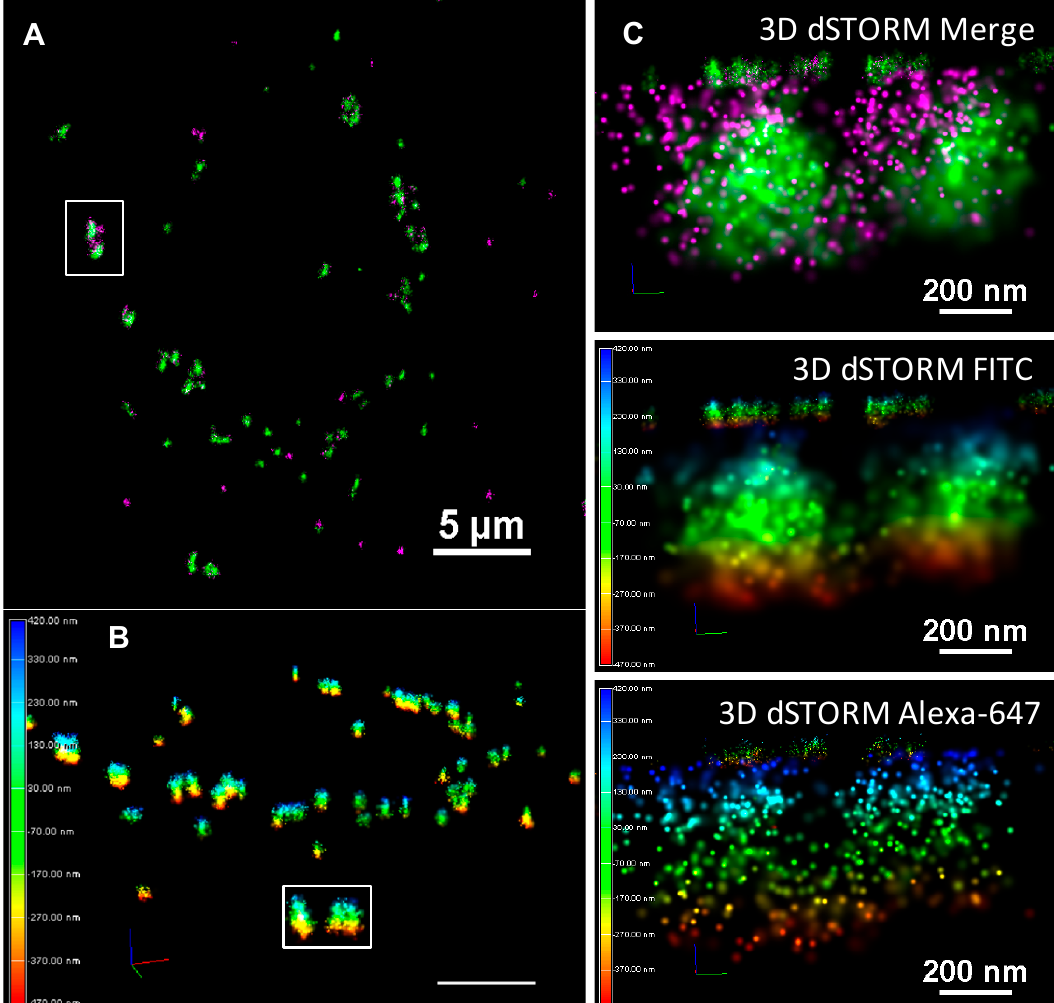
Figure 9. ( A ) 3D STORM imaging of the protein corona in AA4040-coated TiO 2 NMs after 18 h incubation in A549 Cells. A 3D STORM acquisition of cells treated with TiO 2 –AA4040 shows the 3D structure of the protein corona. The green signal indicates molecules of the FITC-labeled serum constituting the initial corona, while the magenta signal is representative of Alexa-647-labeled protein comprising secondary adsorption events. ( B ) The color-coded panel represents the distribution of detections in Z, with a range of approximately 800 nm. In this manner, 3D dSTORM allows for true resolution in three dimensions. These images show discrete clusters which lie within 200 nm of one another—as such, diffraction-limited approaches will fail to resolve these as distinct objects. ( C ) In the higher zoom crop of this sample, two smaller agglomerates are observed in close proximity, with a diameter of approximately 600 nm. Of these, the initial corona appears to be comprised of tightly bound, highly localized molecules with a diameter of 300–350 nm, with the exchanged (or soft) corona (Alexa-647) forming a more loosely associated secondary layer. Image presented as a merge (with FITC and Alexa-647 in green and magenta respectively), single channel Z-color coded FITC and Alexa-647 labelled serum.